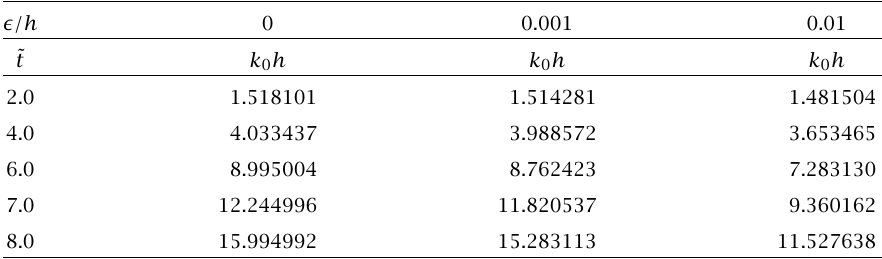
Table 5.2 . ˜ x = 1, N 2 h/g = 0 .